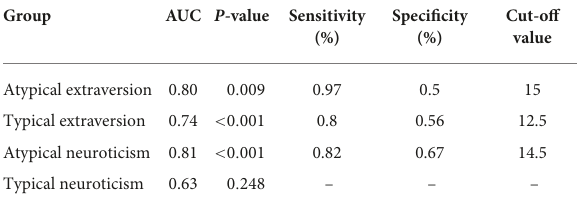
TABLE 4 ROC index of each